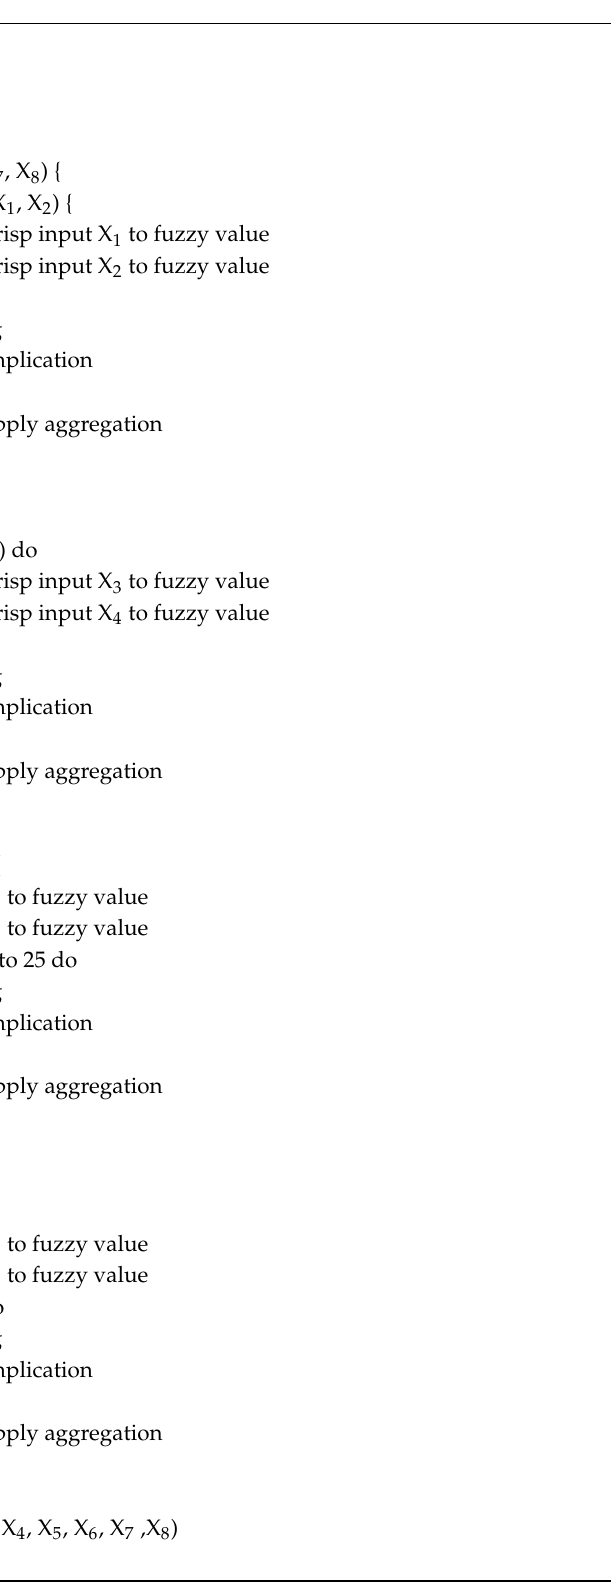
Pseudo code for Blended